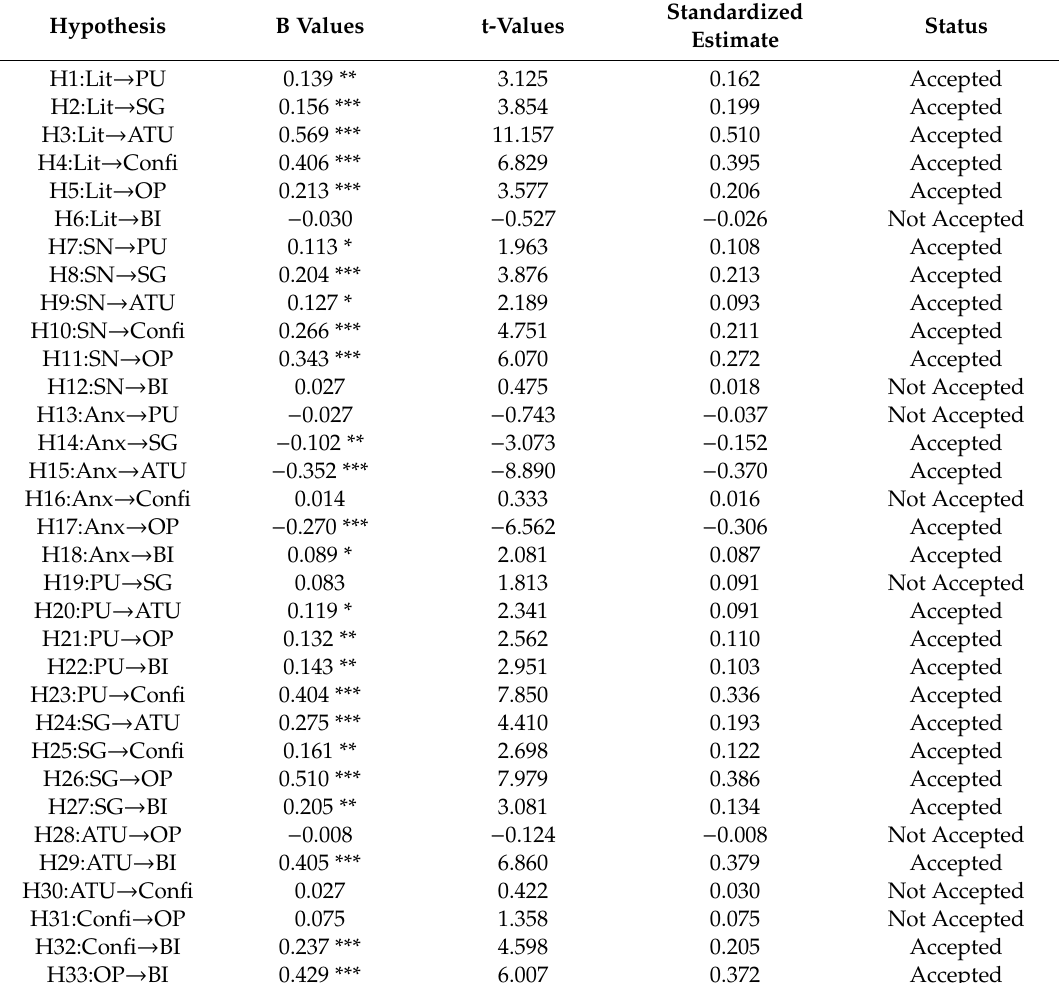
Table 3. Hypotheses testing results from